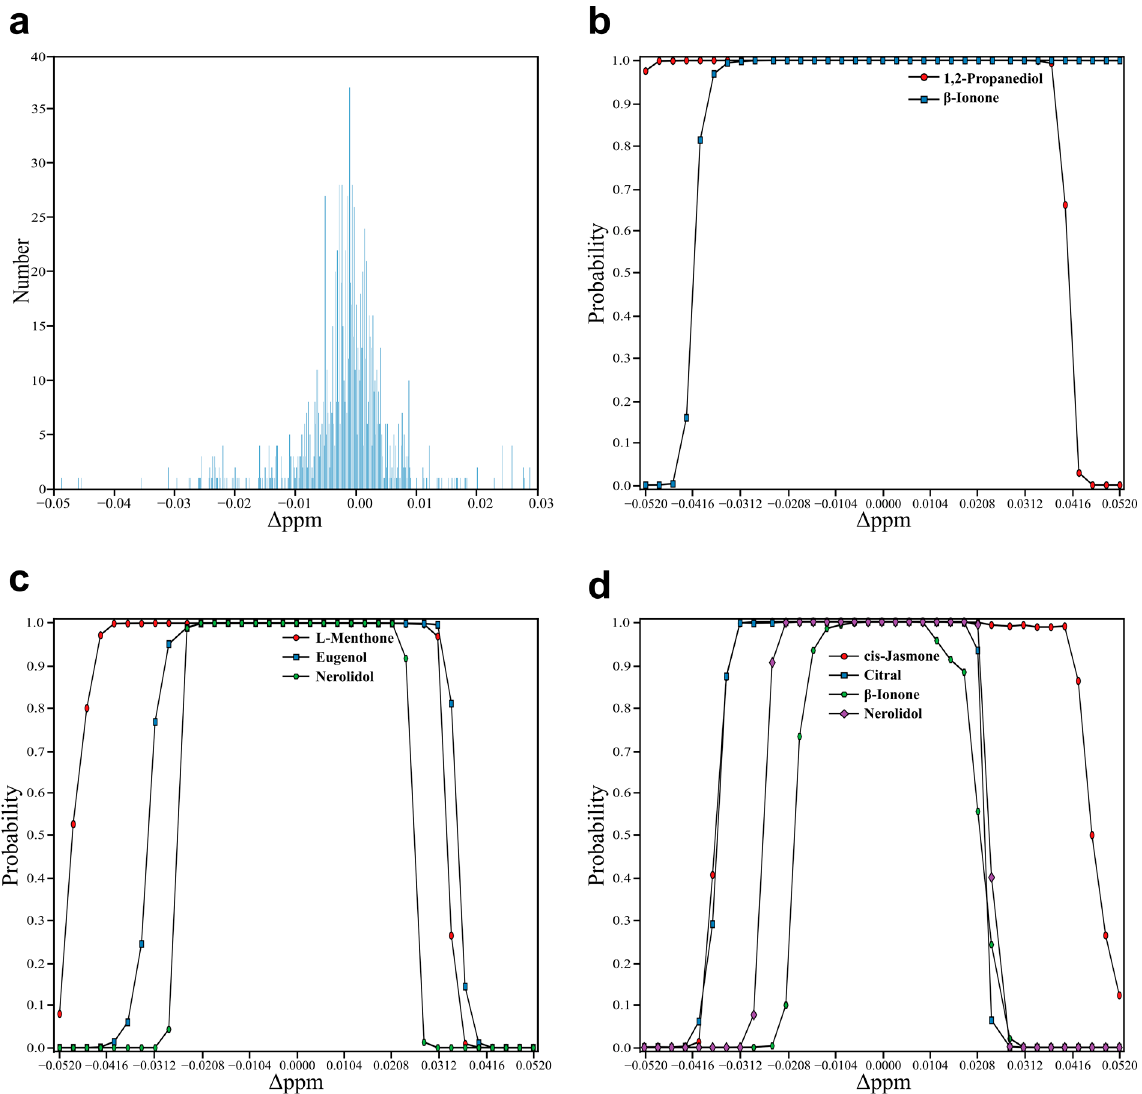
Figure 6. Demonstration of the translation invariance of pSCNN. ( a ) The number of chemical shift variations between all mixtures and their corresponding components. ( b – d ) The probabilities of the corresponding components in mixtures predicted by pSCNN for spectral pairs with different chemical shift variations. The results in ( b – d ) are the spectral pairs with two, three and four components, respectively.